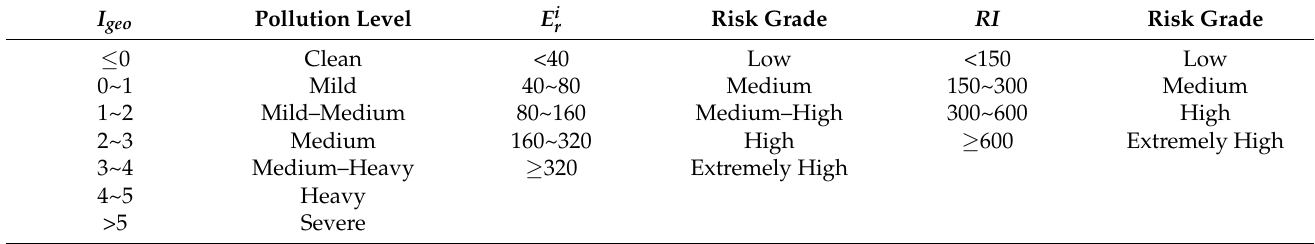
Table 1. Classification of Geoaccumulation Index and Potential Ecological Risks